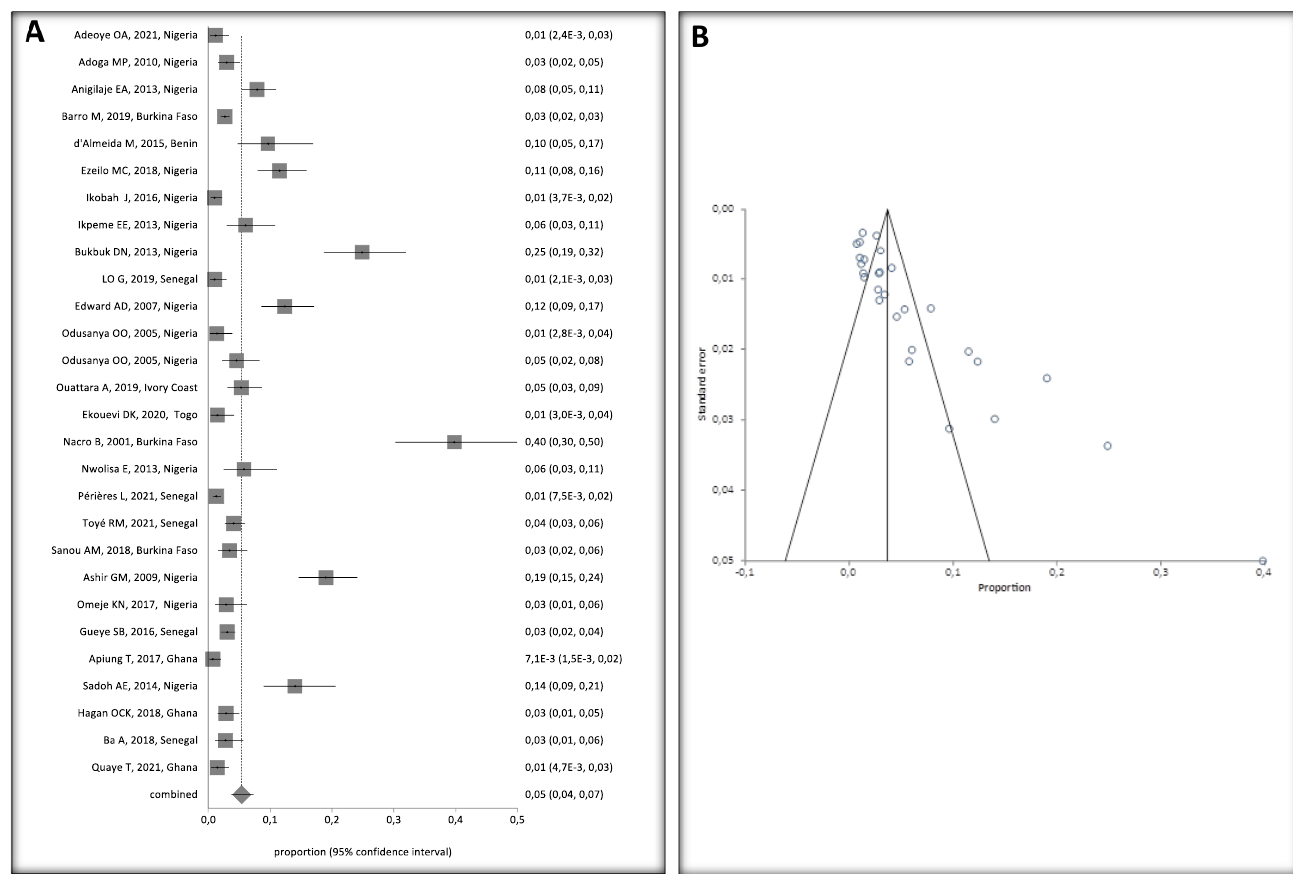
Figure 4. ( A ) Forest Plot of Global HBV Prevalence in Children in West Africa, 2000 and 2021. A black square represents the HBV prevalence in the forest plot. The square position represents the prevalence in each study in the meta-analysis [24 – 34,36 – 50]. ( B ) Bias Assessment Plot.